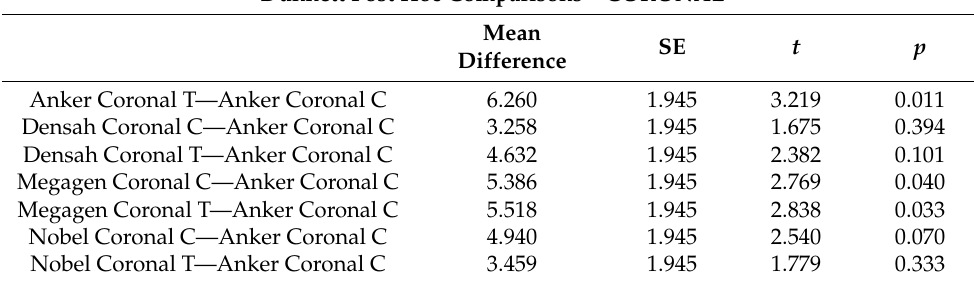
Table 3. Statistical comparison of the relative bone condensation at the coronal region for all of the groups. No significant differences were observed between groups. T = Test, C = Control, SE = Standard Error, t = test, p = p value.